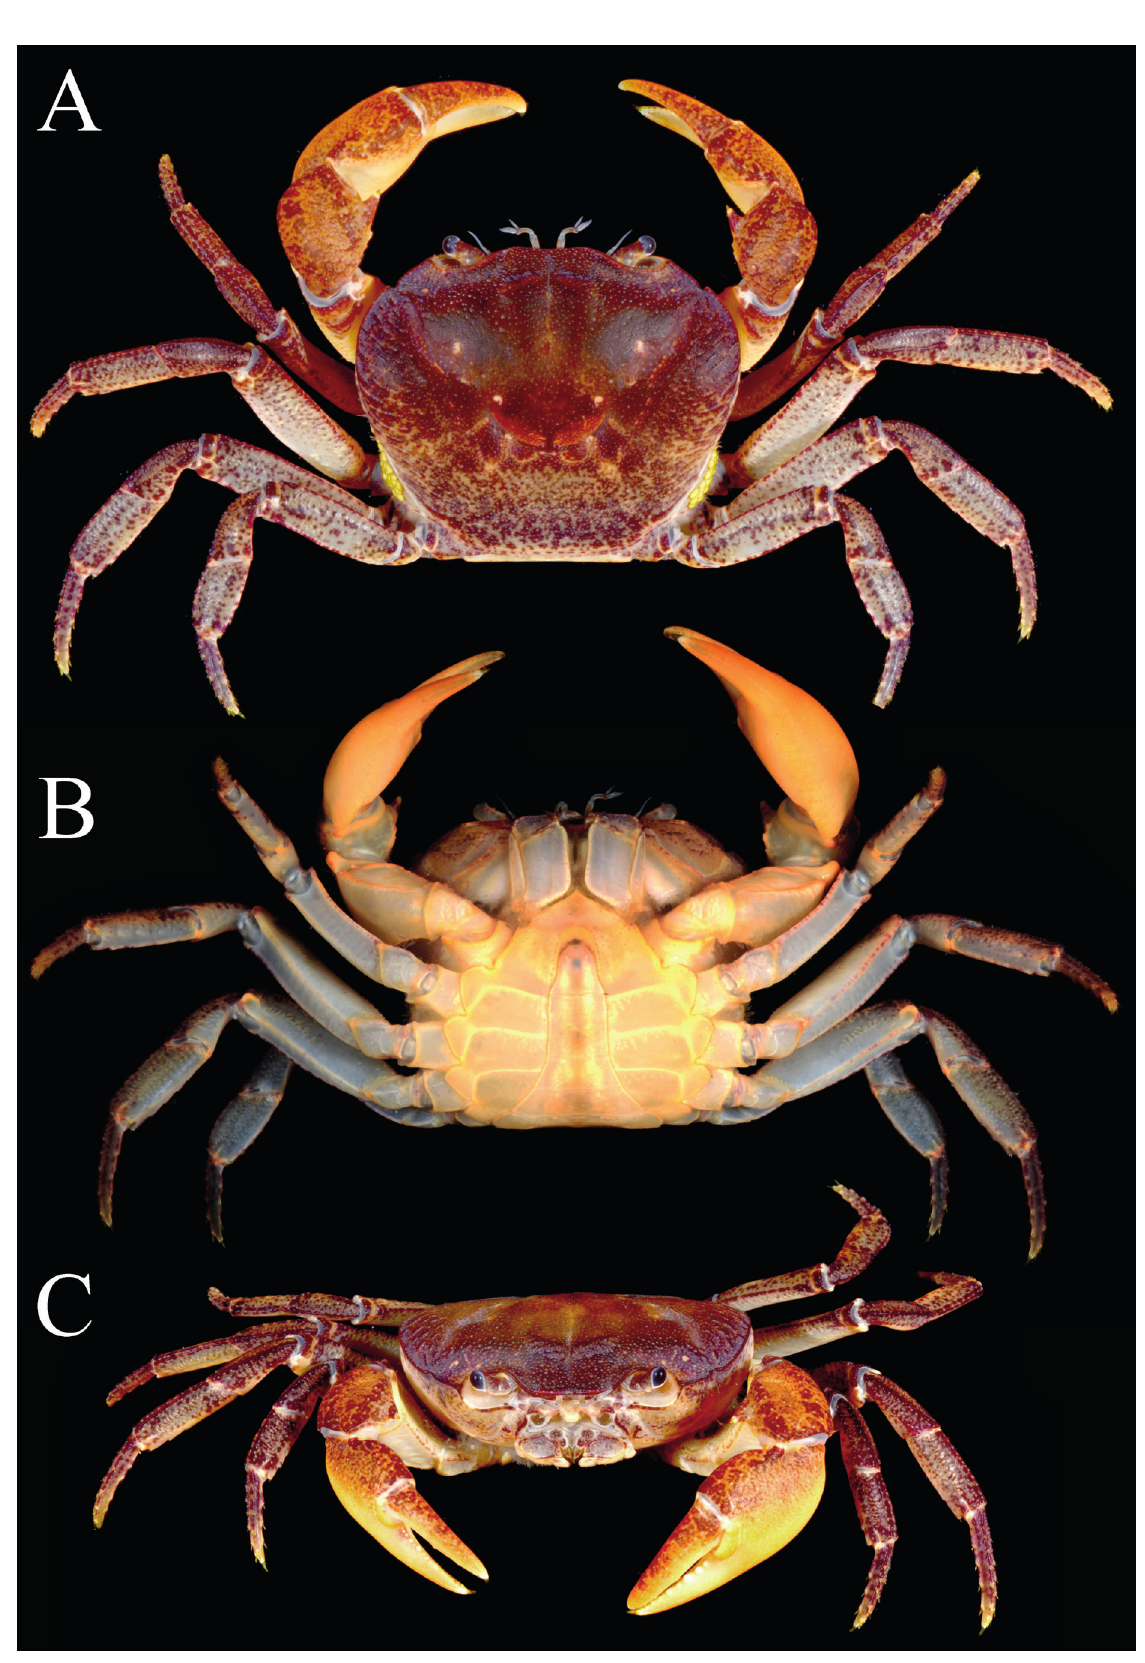
Figure 1. Sundathelphusa tuerkayi , new species, colour in life, paratype, male (24.0 × 18.9 mm) (ZRC 2014.0854), Lombok, Indonesia. A, dorsal view (note bright yellow-greenish eggs of symbiotic temnocephalid flatworm on left and right branchiostegia, see also Fig. 6); B, ventral view; C, frontal